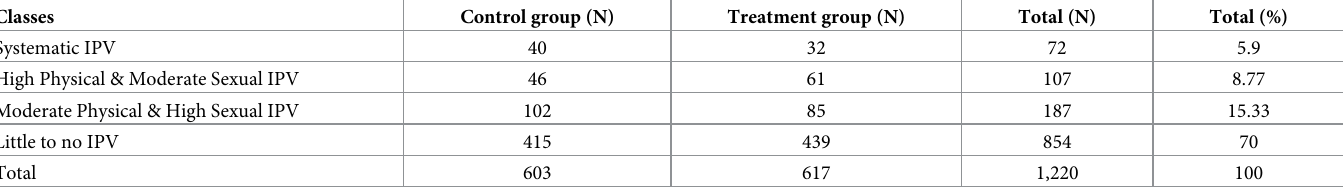
Table 3. Latent subgroups of couples defined using women’s experience of IPV at